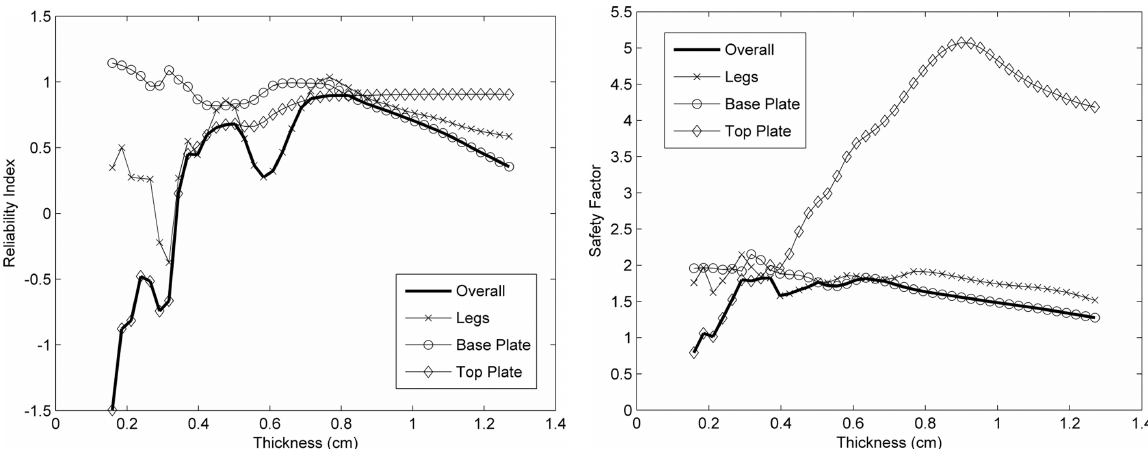
Fig. 10. Reliability indices vs. top plate thickness for structure from Fig. 7.